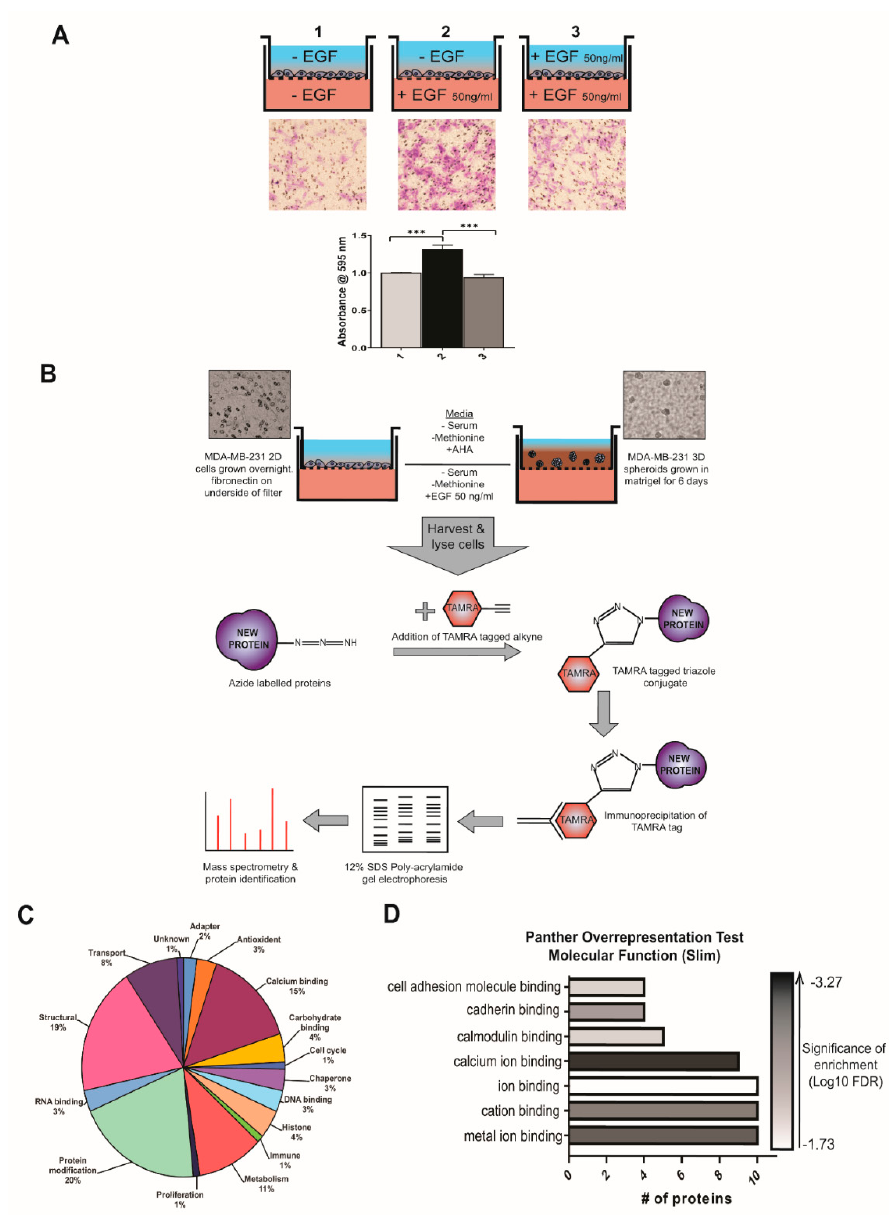
Figure 1. Isolation, identification, and functional characterization of newly synthesized proteins in MDA-MB-231 migration and invasion. ( A ) MDA-MB-231 cells were plated in the upper chamber of transwell plates and media was supplemented ( +/ − EGF) according to diagram. Cell migration after 4 h was measured by crystal violet (CV) staining of cells which moved through the well and adhered to the underside of the membrane. Non-migrated cells were removed prior to staining. Membranes were then imaged using inverted microscope and migration of cells was quantified by dissolving of CV stain and measuring absorbance at 595 nm. Data displayed as mean ± SEM, of 3 independent experiments, CV absorbance normalized to average value for well 1. Statistical analysis by one way ANOVA, p = < 0.0001. ( B ) Flow chart of model set-up, isolation of newly synthesized proteins, and mass spectrographic analysis carried out in this study. ( C ) Characterization of identified newly synthesized proteins according to the NCBI database entries of each protein and displayed as pie chart. ( D ) Molecular function enrichment analysis was carried out using the PANTHER overrepresentation test. The numbers of proteins annotated with each molecular function was plotted as a bar chart with the color scale representing the significance of the enrichment of molecular function within the